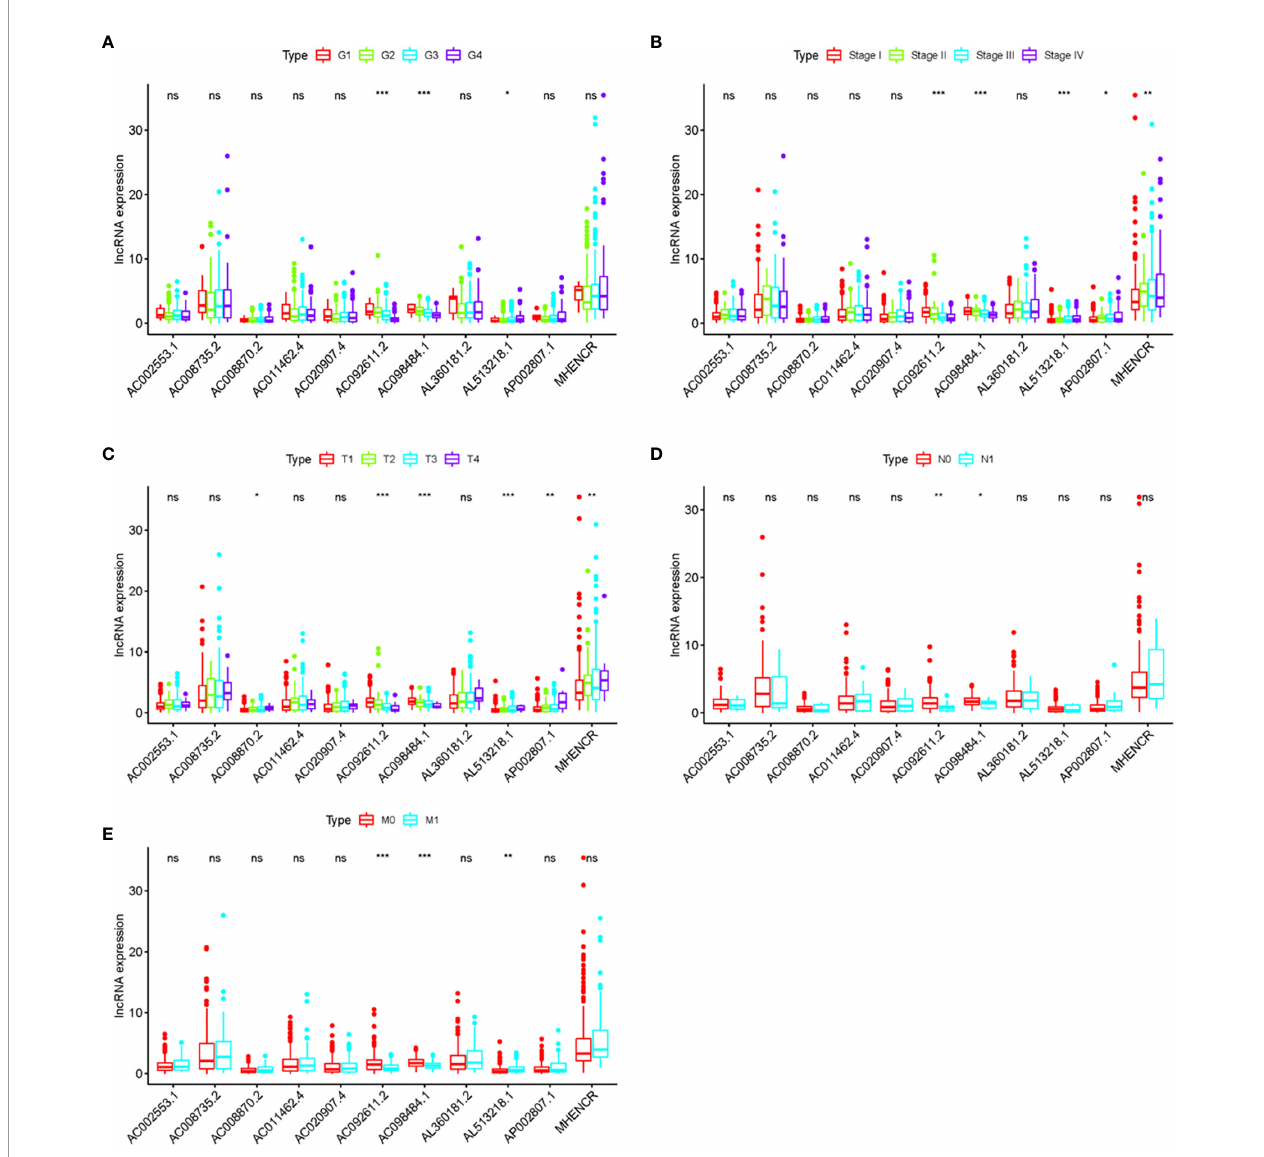
FIGURE 5 | The relationships between the clinical features and sARLNRs. Relationships between 11 sARLNRs (AC002553.1, AC092611.2, AL360181.2, AP002807.1, AC098484.1, AL513218.1, AC008735.2, MHENCR, AC020907.4, AC011462.4, and AC008870.2) and clinical features were shown in (A – E) . The expression levels of AL513218.1 were decreased in the early stage, grade, T-stage, and M-stage; the expression levels of AP002807.1 and MHENCR were increased in the advanced stage and T-stage; the expression levels of AC008870.2 were enhanced in the advanced T-stage. (***p < 0.001; **p < 0.01; *p < 0.05; ns = p >